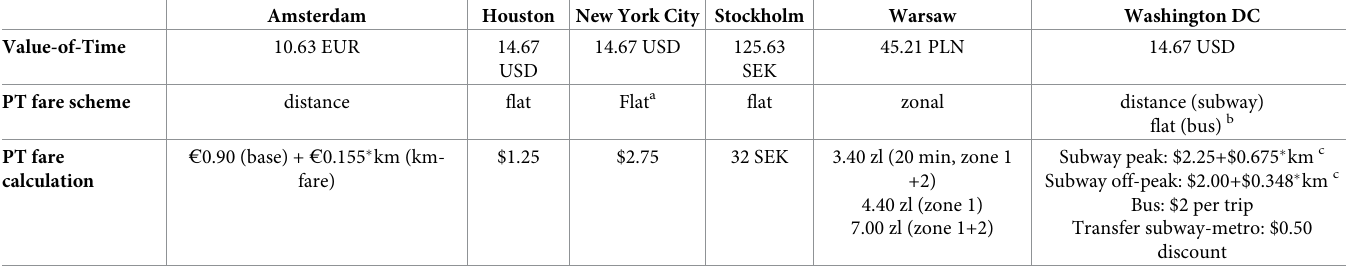
Table 2. Summary of case-specific